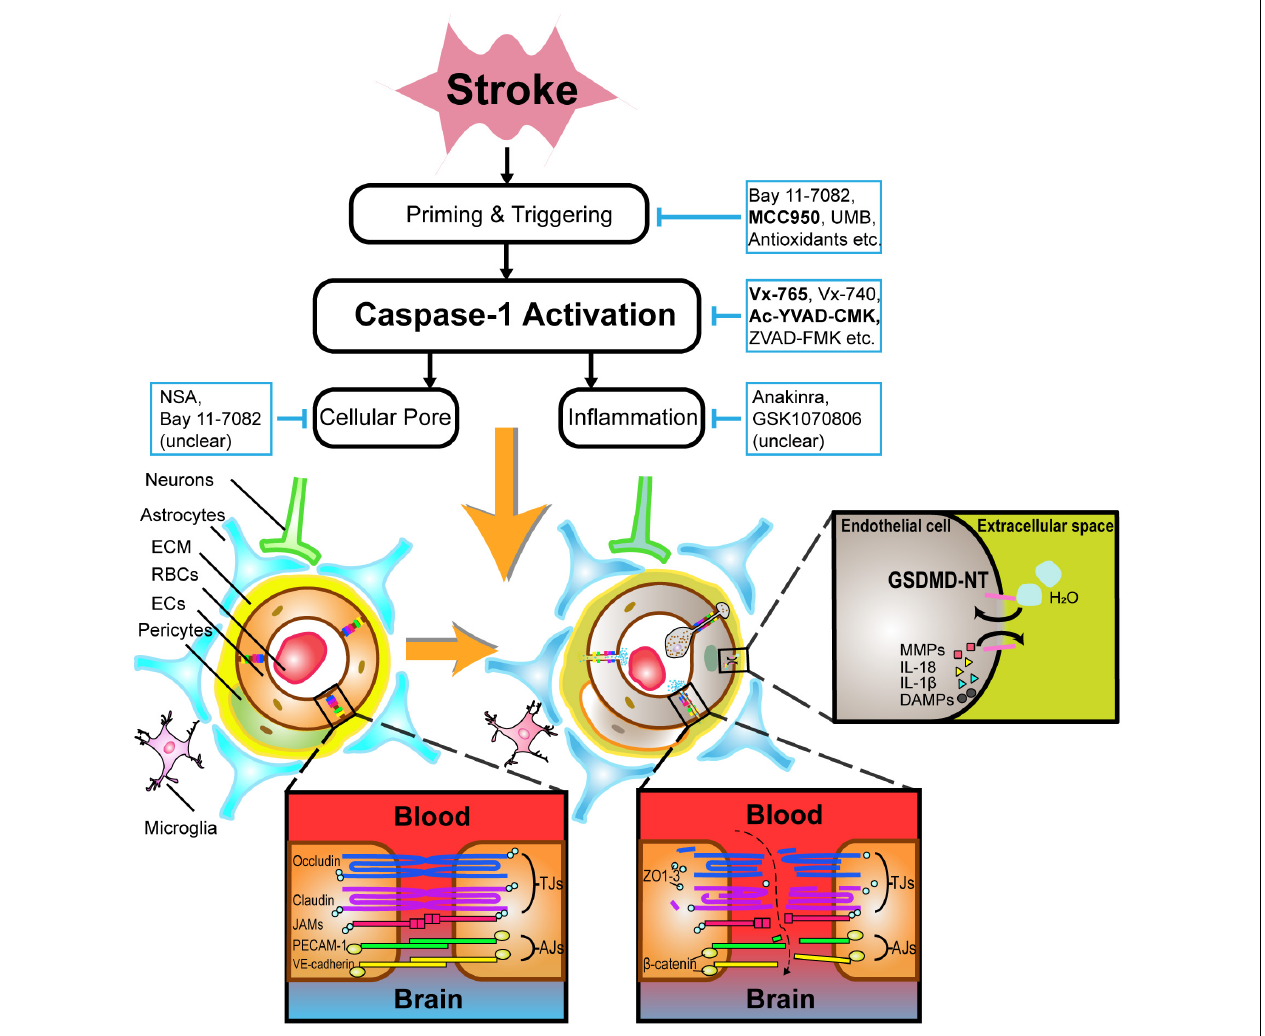
FIGURE 2 | An illustration of the pathophysiology underlying caspase-1-mediated blood–brain barrier injuries and potential drugs targeting caspase-1-associated pathways in acute stroke. After caspase-1 activation, not only BBB components such as endothelial cells and astrocytes undergo lytic cellular death, but BBB supporting structures such as neurons and microglia are subject to pyroptosis likewise. In particular, the phosphorylation of tight junction proteins, particularly occludins and claudins, contribute to BBB hyperpermeability. GSDMDNT-mediated pore formation brings about the exchange of ions and water molecules together with inflammatory cytokines, cumulating in cellular swelling and lysis. Caspase-1-related neutrophils and lymphocytes transmigration also drive BBB disintegration to some extent. Alternatively, selective inhibitors of caspase-1-associated pathways such as Vx-765, Ac-YVAD-CMK, MCC950, etc., are promising in alleviating BBB injuries during acute stroke. ECM indicates extracellular matrix; RBCs, red blood cells; ECs, endothelial cells; IL, interleukin; DAMPs, damage-associated molecular patterns; MMPs, matrix metalloproteinases; GSDMDNT, N-terminal fragment of gasdermin